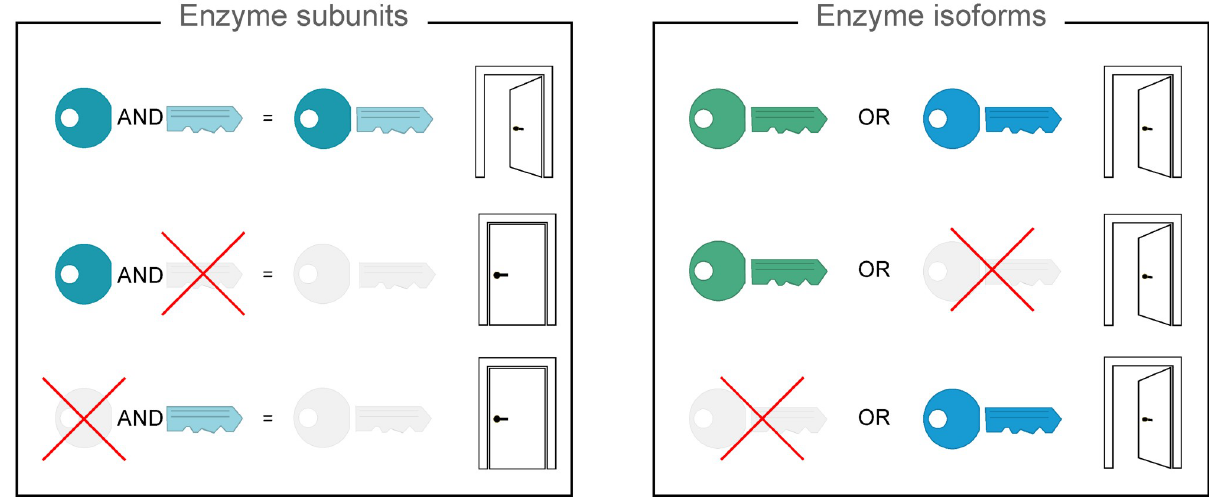
Fig 1. Logic of GPR rules. A metaphorical representation is exploited to explain the meaning of the AND and OR operators used in the reconstruction of GPR rules. In the box on the left named “Enzyme subunits”, the AND operator joins genes encoding for different subunits of the same enzyme. Metaphorically, the head and tail of the key represent the subunits of the same enzyme. Both parts of the key are required to open the door, and the lack of one of the two parts precludes the opening of the door. Biologically speaking, when both the subunits forming the enzyme are available, the enzyme can catalyse the reaction where it is involved. In the box on the right named “Enzyme isoforms”, the OR operator joins genes encoding for different isoforms of the same enzyme. In this case, two distinct keys representing the enzyme isoforms can alternatively open the door. Differently from the previous situation, just one of the two isoforms is sufficient to catalyse the reaction. Combining AND and OR operators, more complex scenario can be describe where both isoforms and subunits are involved.